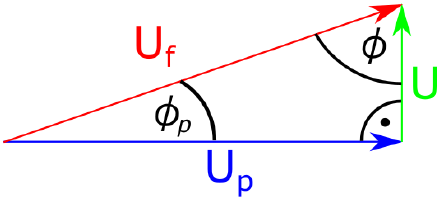
Figure 2. Vector representation of fluid velocity amplitude U f , particle velocity amplitude U p , and slip velocity amplitude U , including phase shift angles in reference to the fluid oscillation of the particle velocity φ p and slip velocity φ ,